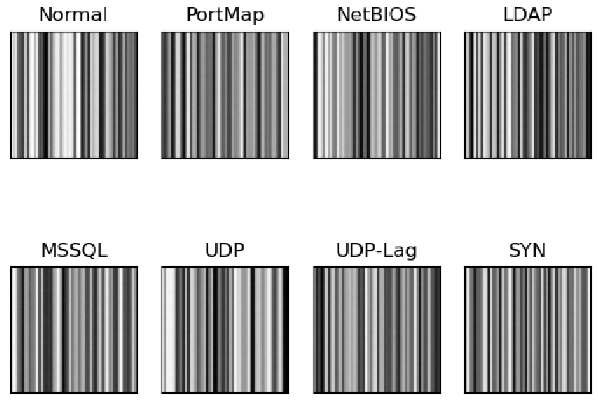
Figure 7. Images after image embedding for each class.